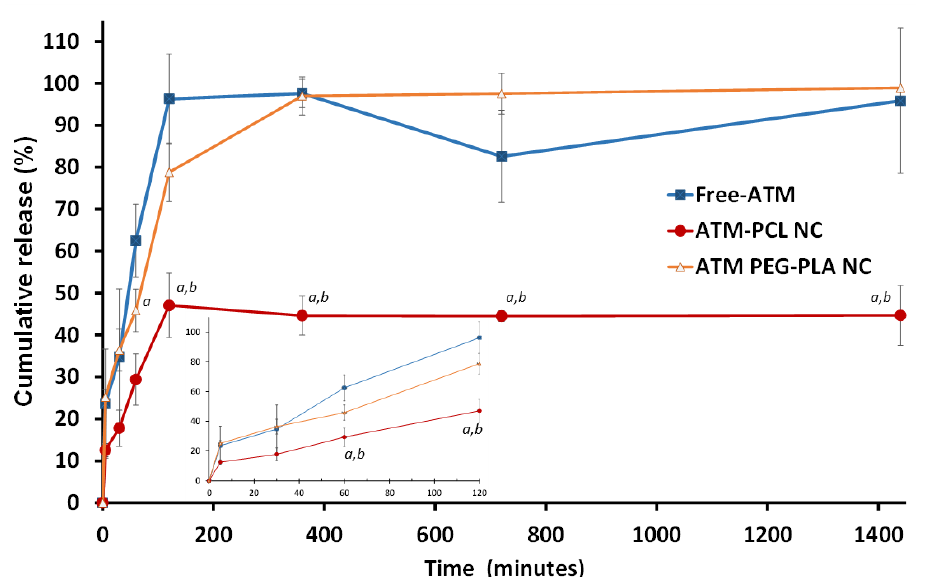
Figure 3. Profiles of the cumulative release of free-artemether (Free-ATM) and artemether from nanocapsules of polycaprolactone and PEG-PLA polymers following time in PBS pH 7.4 under sink conditions in 37 ◦ C using inverted dialysis sac method. The insert represents the first 2 h. Data shown are means ± standard deviations of n = 3 independent experiments. The assay was made in triplicate (nine measurements in total). a is a mean statistically different from free-ATM and b statistically different from ATM-PEG-PLA NC. The values at each time point were compared using an unpaired student’s t